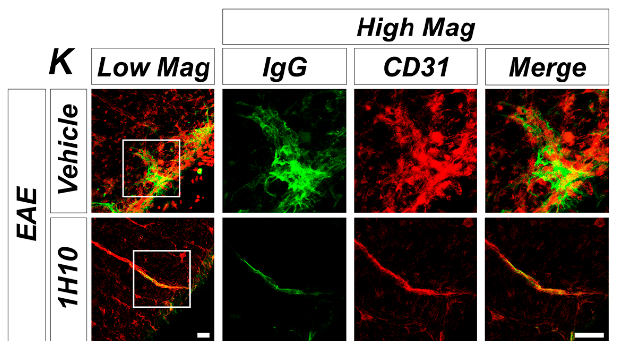
Figure 4. 1H10 reduces aberrant synaptic zinc patches, Matrix metallopeptidase 9 (MMP-9) activation, and blood-brain barrier (BBB) disruption in the white matter of the spinal cord in EAE. ( A ) Representative images showing sections of the spinal cord stained with N -(6-methoxy-8-quinolyl)-para-toluenesulfonamide (TSQ) to detect zinc accumulation. Scale bar, 100 µ m. WM = white matter, GM = grey matter. ( B ) Quantification of TSQ intensity in the white matter of the spinal cord (mean SEM; n = 3 per group). * p < 0.05 vs. ± vehicle-treated EAE mice; # p < 0.05 vs. sham-operated mice (Kruskal-Wallis test followed by Bonferroni post-hoc test: Chi square = 9.359, df = 3, p = 0.025). ( C ) Double label confocal micrographs of synaptophysin (green) and zinc transporter 3 ( ZnT3 , red) in the spinal cord from vehicle- and 1H10-treated EAE mice. Scale bar, 20 µ m. WM = white matter, GM = grey matter. ( D , E ) Quantification of the immunofluorescence intensity of synaptophysin ( C ) and ZnT3 ( D ) as determined in the same spinal cord region (mean ± SEM; n = 3 per group). * p < 0.05 vs. vehicle-treated EAE mice (unpaired Student’s t -test). ( F ) Immunofluorescence images representing the expression of MMP-9 in the white matter of the spinal cord. Scale bar, 50 µ m. ( G ) Bar graph showing the percent areas of MMP-9 immunoreactivity in the thoracic spinal cord with or without 1H10 treatment in sham-operated and EAE mice (mean SEM; n = 3 per group). * p < 0.05 vs. ± vehicle-treated EAE mice; # p < 0.05 vs. sham-operated mice (Kruskal-Wallis test followed by Bonferroni post-hoc test: Chi square = 9.392, df = 3, p = 0.025). ( H ) Photomicrographs showing sections of the spinal cord stained for anti-mouse immunoglobulin G (IgG) to detect endogenous IgG. Scale bar, 100 µ m. ( I,J ) Graph representing the intensity ( I ) or percent area ( J ) of IgG leakage from the spinal cord in mice treated with vehicle or 1H10 at 3 weeks following the initial immunization (mean SEM; n = 4–5 per group). * p ± < 0.05 vs. vehicle-treated EAE mice; # p < 0.05 vs. sham-operated mice (Kruskal-Wallis test followed by Bonferroni post-hoc test: Chi square = 15.436, df = 3, p = 0.001). ( K ) Double label confocal micrographs of CD31 + endothelial cells (red) and endogenous mouse IgG molecules (green) in the white matter of the spinal cord from vehicle- and 1H10-treated EAE mice. Scale bar, 20 µ m.